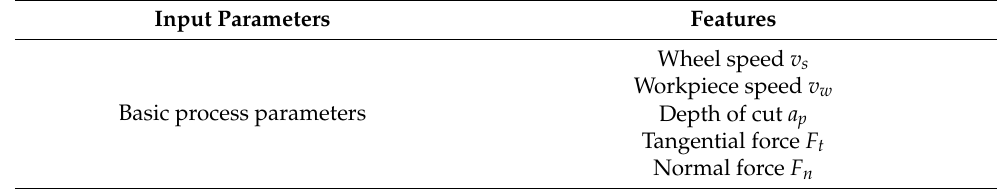
Table 3. Input parameters of the prediction model.